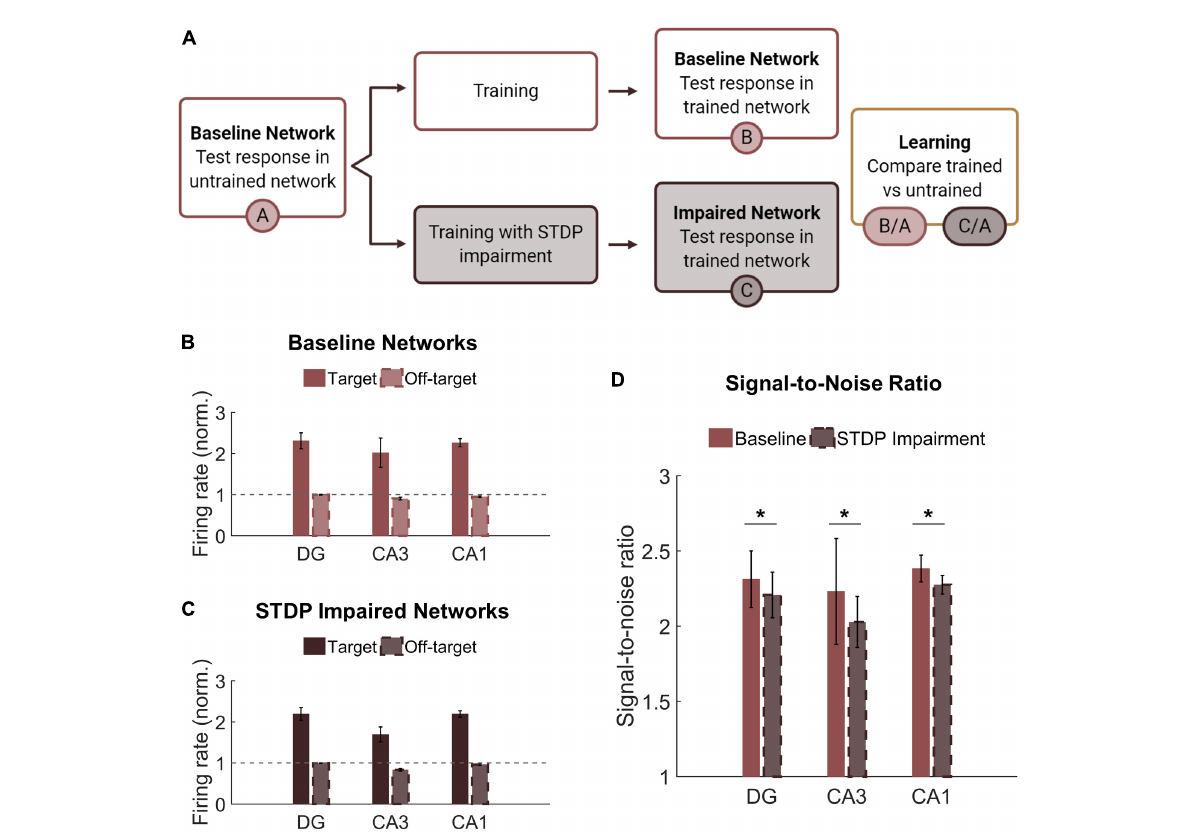
FIGURE6 Networks successfully encode patterned responses although STDP impairment decreases the signal-to-noise ratio. (A) Training consisted of stimulating sets of 200 neurons in the DG. Baseline networks were trained once with STDP impairment and once under control STDP conditions. Networks were tested before and after training to compare the activity response in each region. (B) Firing rates after training are normalized by the response to stimulation in the untrained network. The gray dashed line is the reference point for activity in untrained baseline networks. The activity of target neurons increases significantly from baseline while the average activity of off-target neurons remains the same or decreases. (C) Networks with STDP impairment exhibit the same paradigm as baseline networks with higher activity in target neurons than in off-target neurons. (D) The signal-to-noise ratio (on-target divided by off-target response) decreases significantly after injury in each region (paired Student’s t -test, p < 0.02 with significance determined by Bonferroni